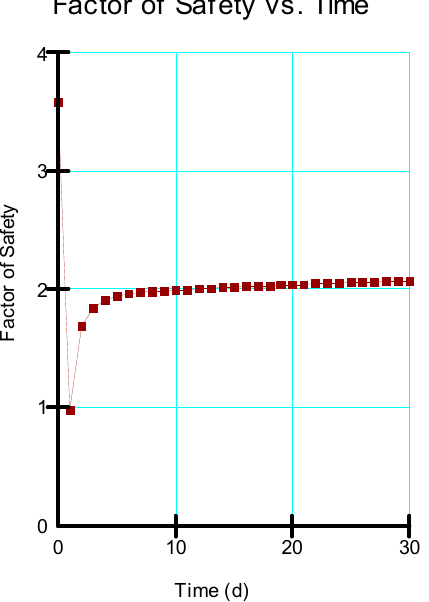
Factor of Safety vs. Time